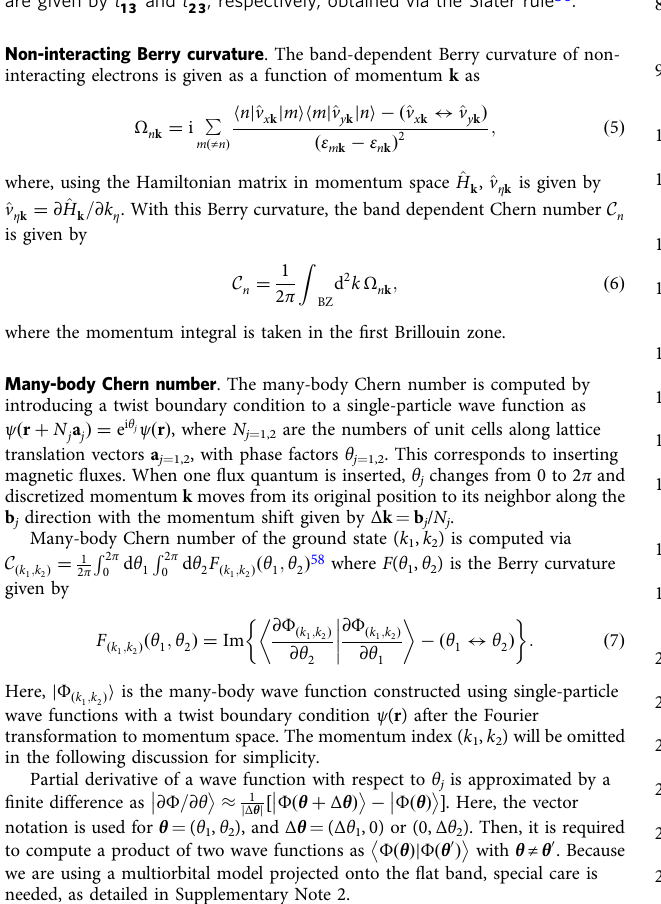
Fig. 6 Second neighbor hopping matrices. yz ( xz ) orbitals between site 1 and site 2 are hybridized via diagonal hopping t ð 2 Þ π ð δ Þ , i.e., π ( δ ) bonding. Other hopping integrals between site 1 and site 3 and between site 2 and site